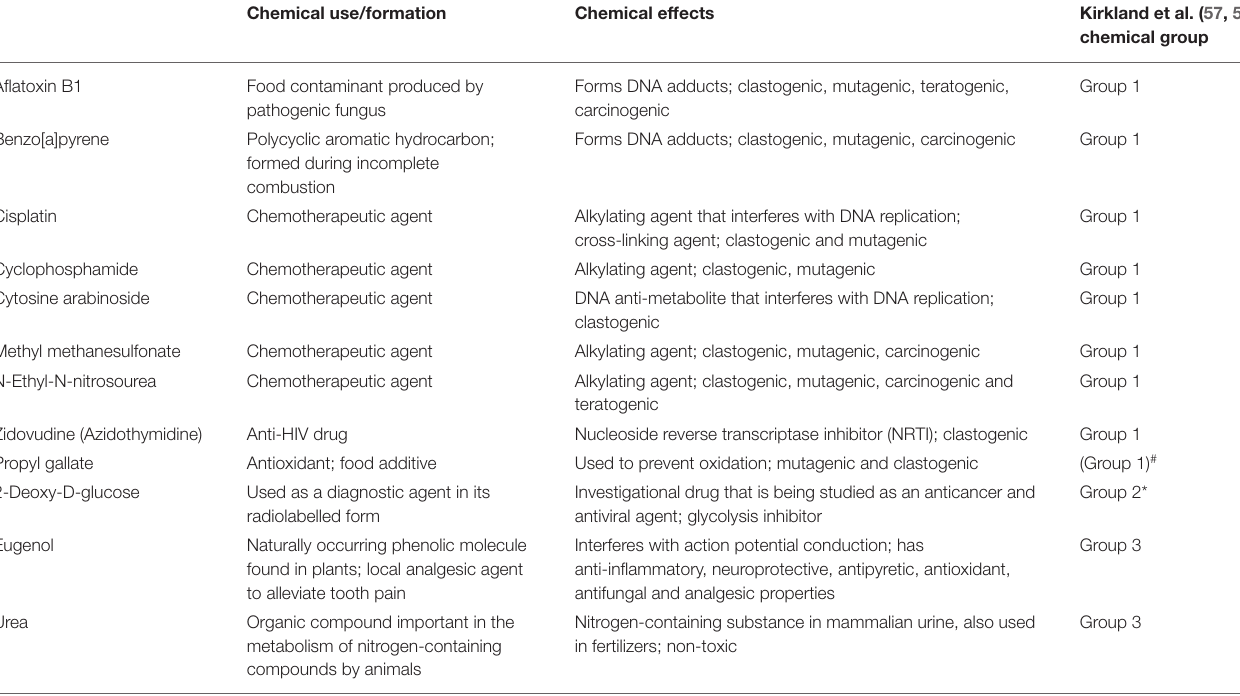
TABLE 1 | Test chemical information for Group 1 (genotoxic/DDI chemicals), Group 2 (non-genotoxic/non-DDI chemicals), and Group 3 (misleading/irrelevant positive chemicals) based on the recommended genotoxic and non-genotoxic chemicals for assessment of the performance of new or improved genotoxicity tests by Kirkland et al. (57,